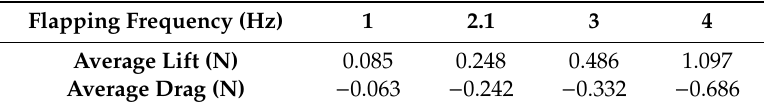
Table 5. Average lift and drag forces produced by the wing at di ff erent flapping frequency with pitching angle 0 ◦ ~60 ◦ at zero flight